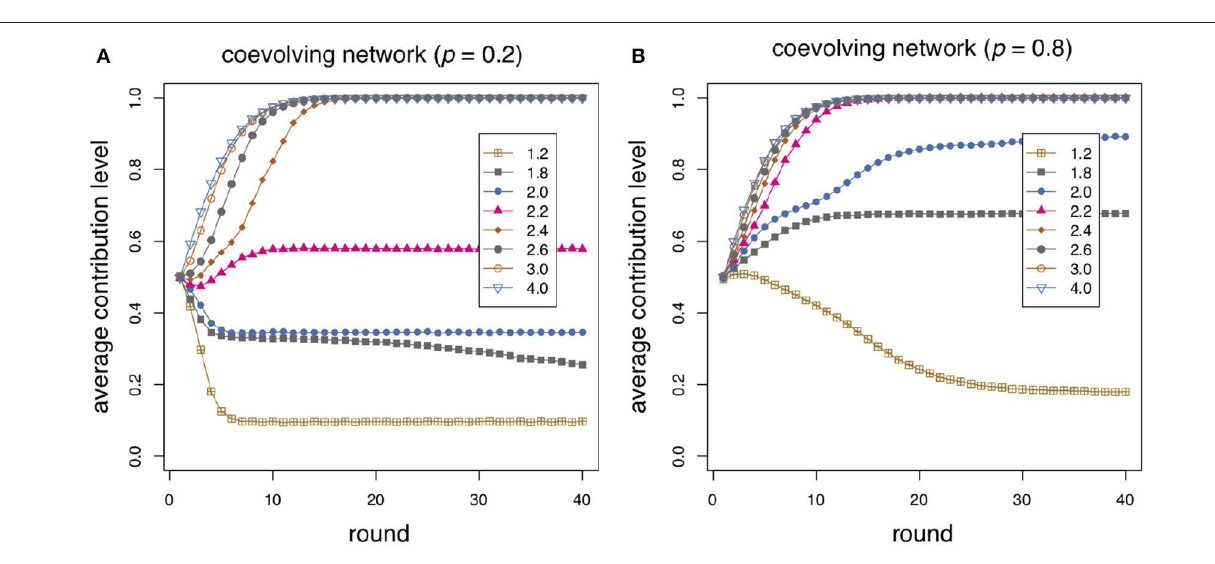
FIGURE 3 | Average individual contribution as a function of round number for several values of the enhancement factor r as shown in the inset. The average is taken over 40 independent repetitions of 40 rounds on an initial network of size 500 and α = 0.3. (A) The probability of rewiring when an agent is unsatisfied is p = 0.2; (B) p =